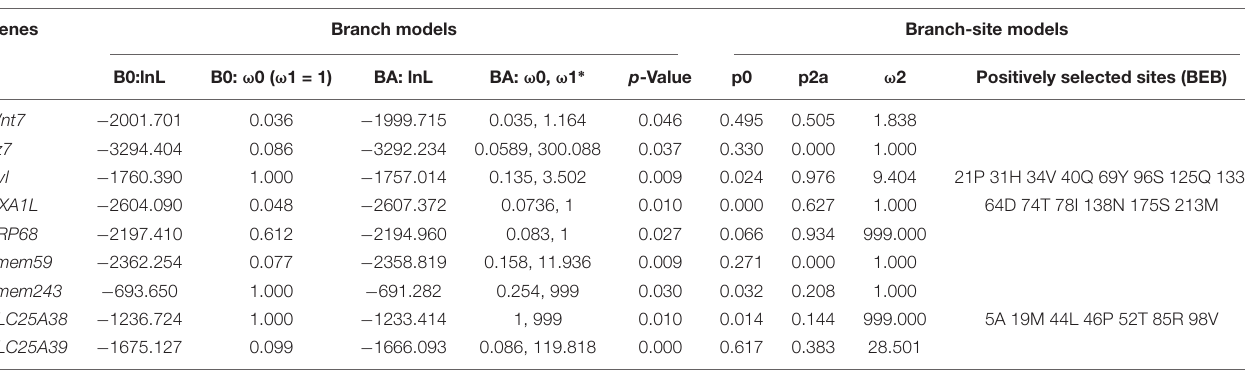
FIGURE 2 | Comparative analysis of genes in regeneration-related signaling pathways of regenerative animals. The comparative analysis are performed on seven regeneration-related signaling pathways of six species. The genes present in genomes are markered in green background, and the genes absent in genomes are markered in other colors according to the legends. TABLE 1 | Positive selected genes related to Wnt signaling pathway and protein